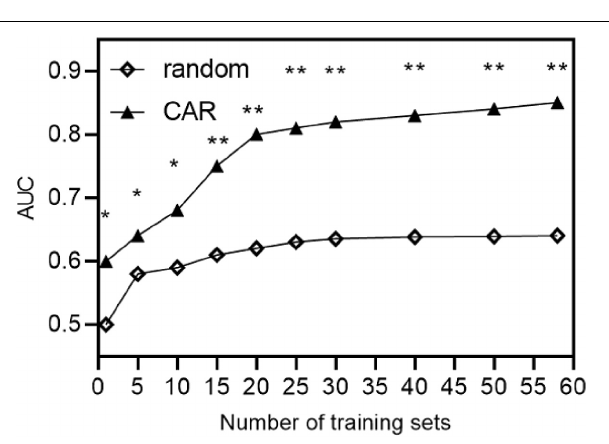
FIGURE 8 | The AUC results of random and order